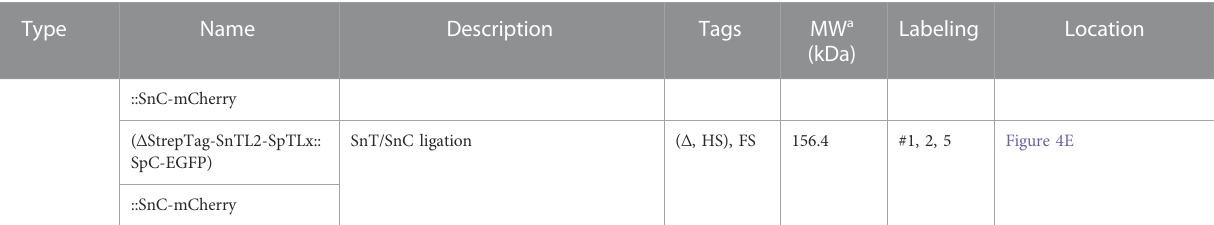
TABLE 2 ( Continued ) Predicted molecular weight for the proteins used in this